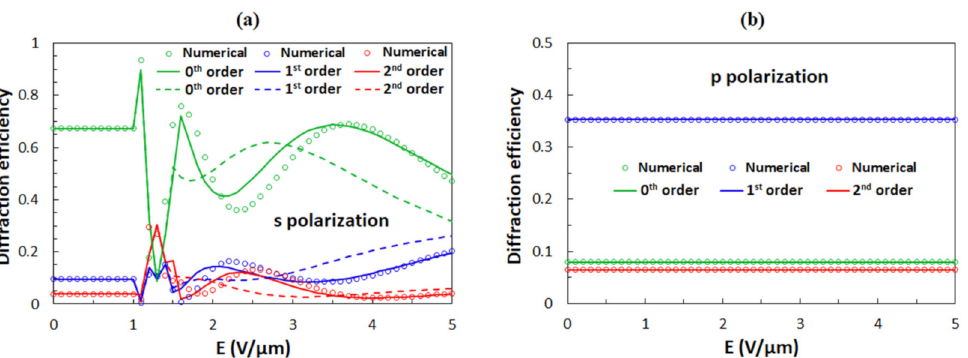
Figure 8. Diffraction efficiencies of the 0th, 1st, and 2nd diffraction orders as a function of the applied external electric field E for ( a ) the s-polarized and ( b ) the p-polarized incident beams. The anchoring strength is W = 100 µ J/m 2 . Circles are obtained with the numerical solution for θ ( x ), while solid lines are results for θ ( x ) obtained by Equation (9) and dashed lines for θ ( x ) obtained by Equation (10). In both analytical cases, for E ≤ 1.4 V/ µ m, results for θ ( x ) are obtained by Equation